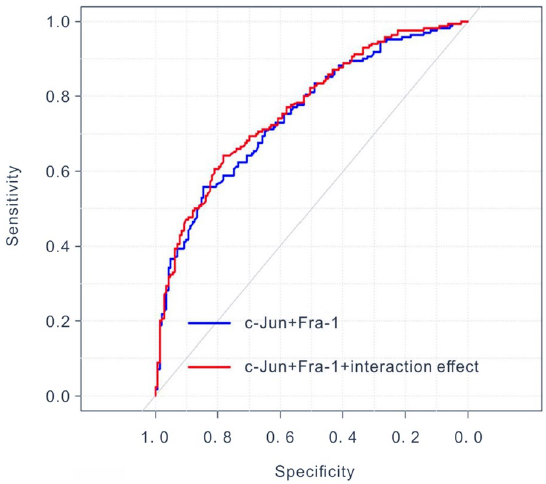
Figure 3. ROC curves for overall survival of OSCC patients with or without interaction effect of c-Jun and